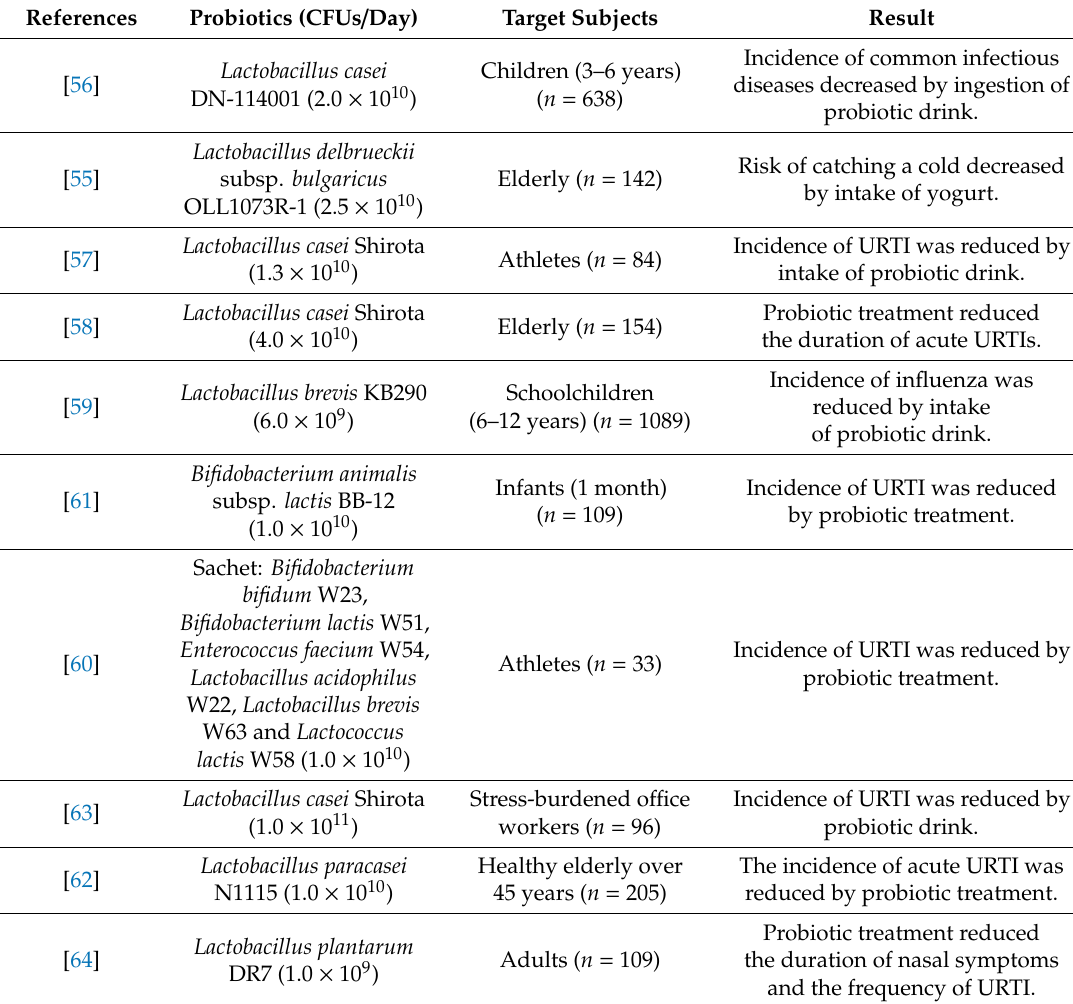
Table 1. E ff ects of probiotics on upper respiratory tract infections (URTIs) in human